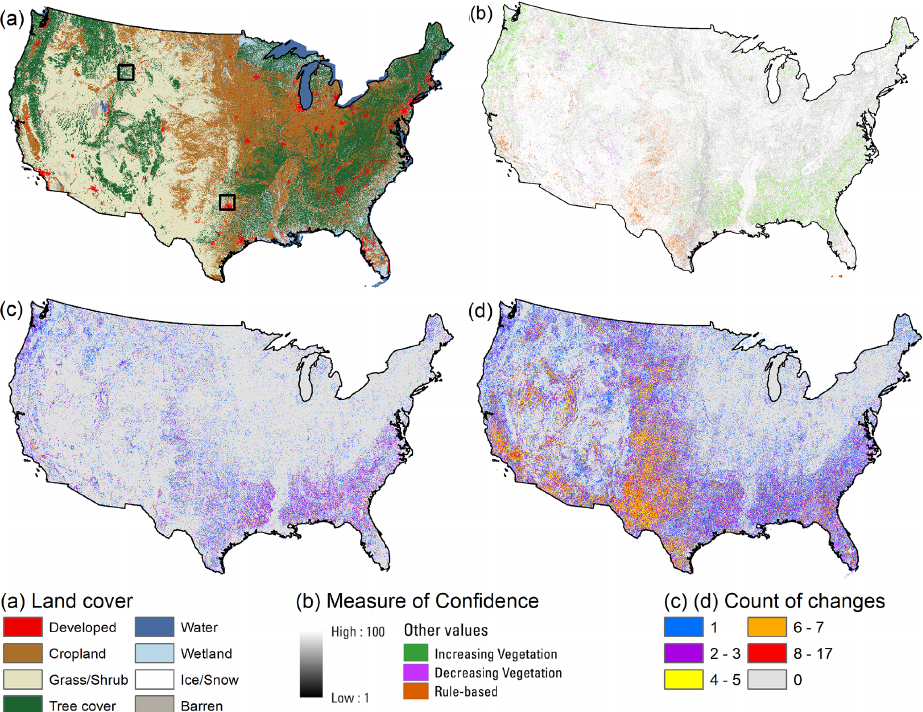
Figure 6. Illustration of the LCMAP product: (a) primary land cover in 2010, (b) primary land cover confidence in 2010, (c) the frequency of land cover changes from 1985 to 2017, and (d) the total number of spectral changes detected from 1985 to 2017.